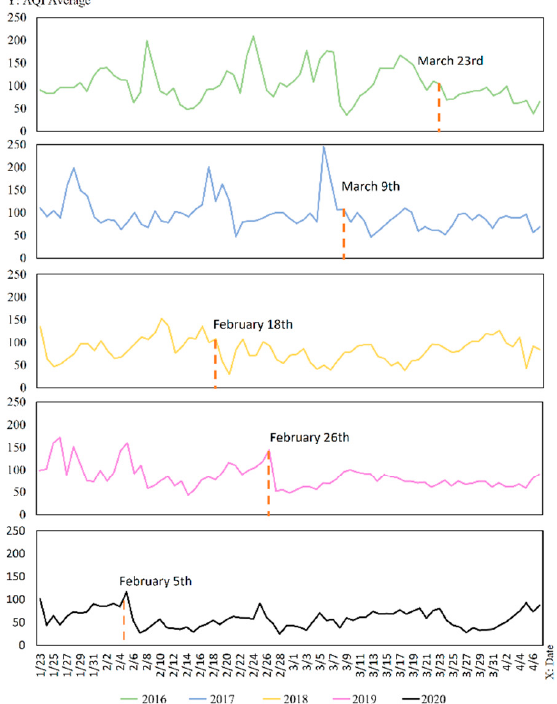
Figure 4. Wuhan City 2016–2019 vs. 2020 AQI change during city closure year-on-year folding chart.